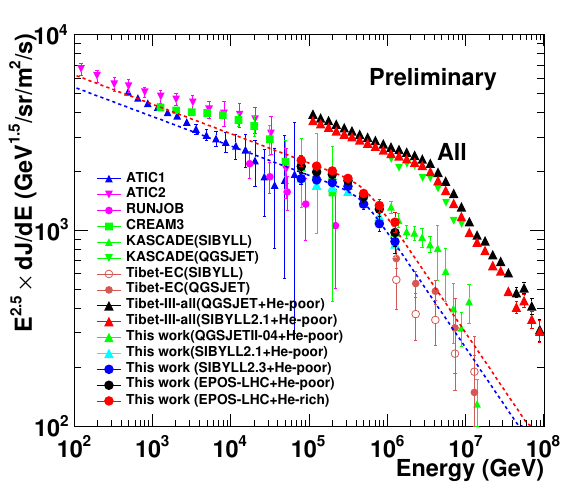
Figure 7. Di ff erential energy spectra of Proton + Helium